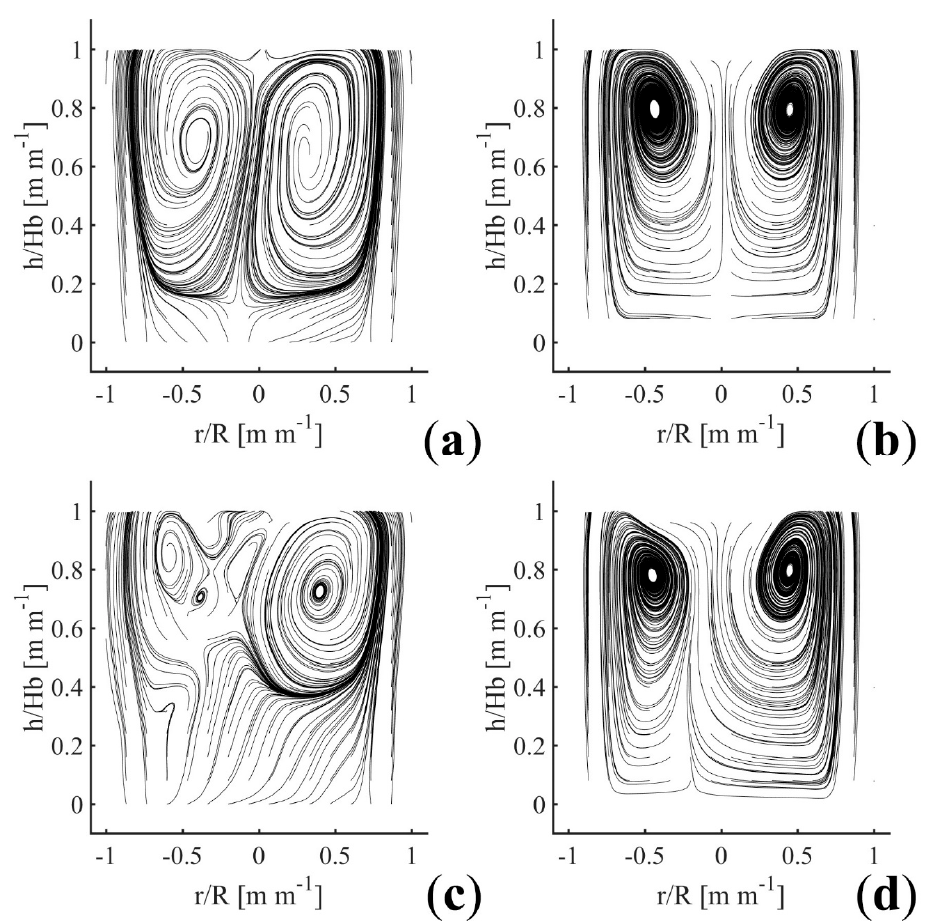
Figure 4. Streamlines obtained for experiment b (Table 2), measured ( a ) and calculated ( b ); and for experiment g (Table 2), measured ( c ) and calculated ( d ).